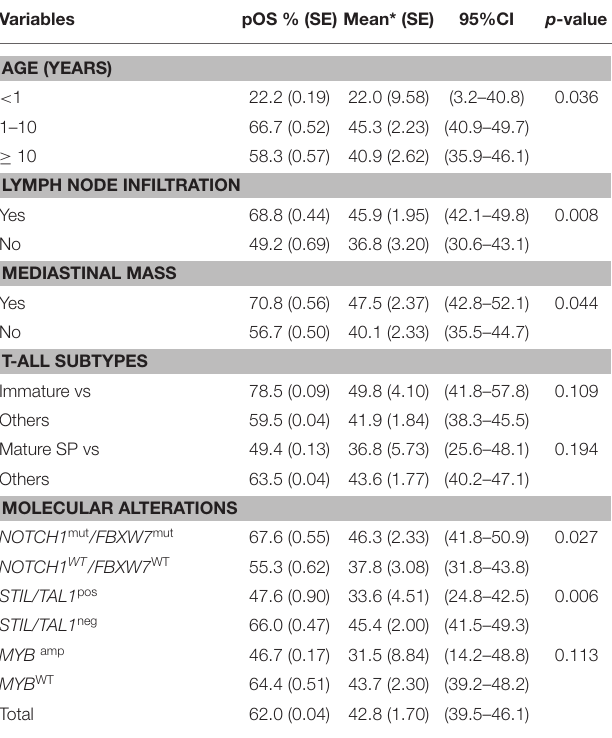
TABLE 3 | Pediatric T-cell acute lymphoblastic leukemia and overall survival in univariate analysis, 2005-2017, Brazil.